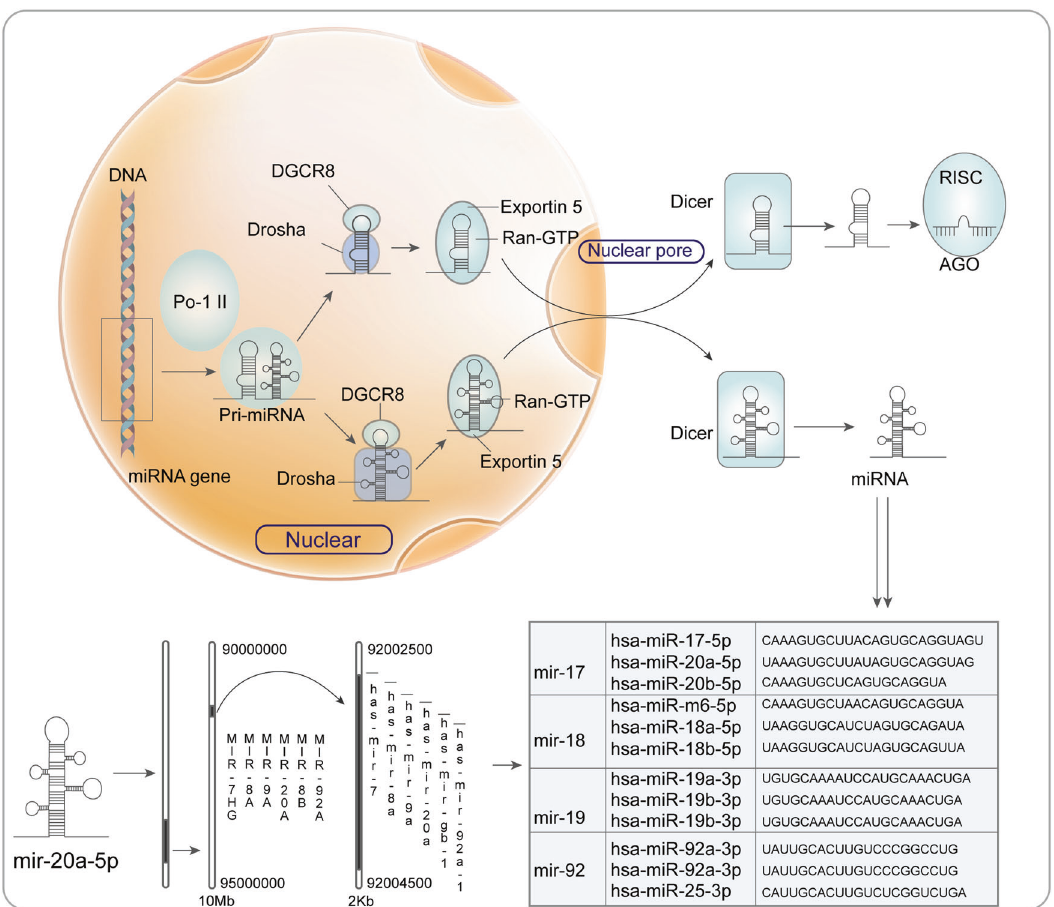
Fig. 1 The biogenesis of miR-20a-5p. miR-20a-5p is fi rst transcribed by RNA polymerase II (Pol II) and pri-miRNA is obtained. Pri-miRNA is cleaved continuously to obtain multiple different miRNAs. In the nucleus, Drosha cuts pri-miRNA, which is exported from the nucleus by binding to RAN-GTP and Exportin 5. In the cytoplasm, Dicer endoribonuclease cleaves the ring structure to produce mature miR-20a-5p. miR- 20a-5p is a family of miR-17, located on human chromosome 13. The sequence and nucleotide sequence of miR-20a-5p gene are shown in the fi